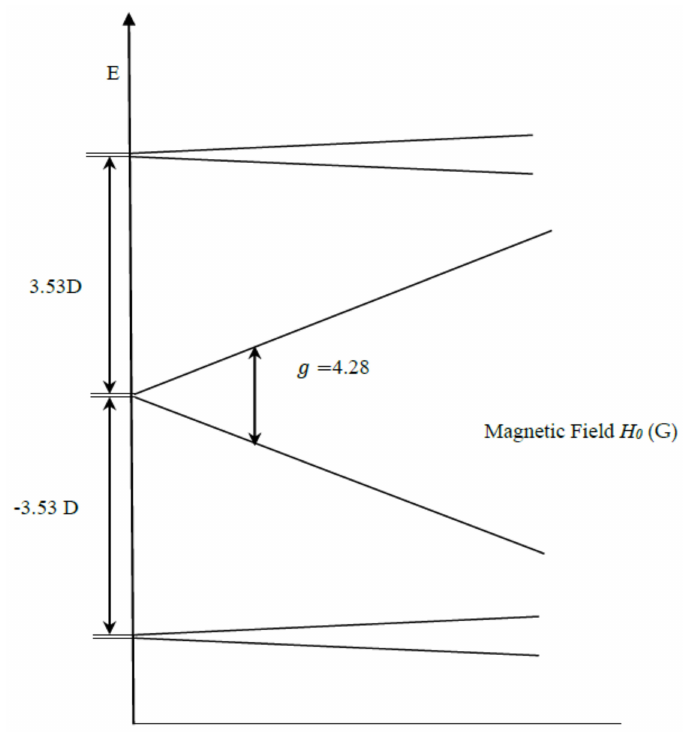
Figure 3. Illustrates the pure rhombic spin 5